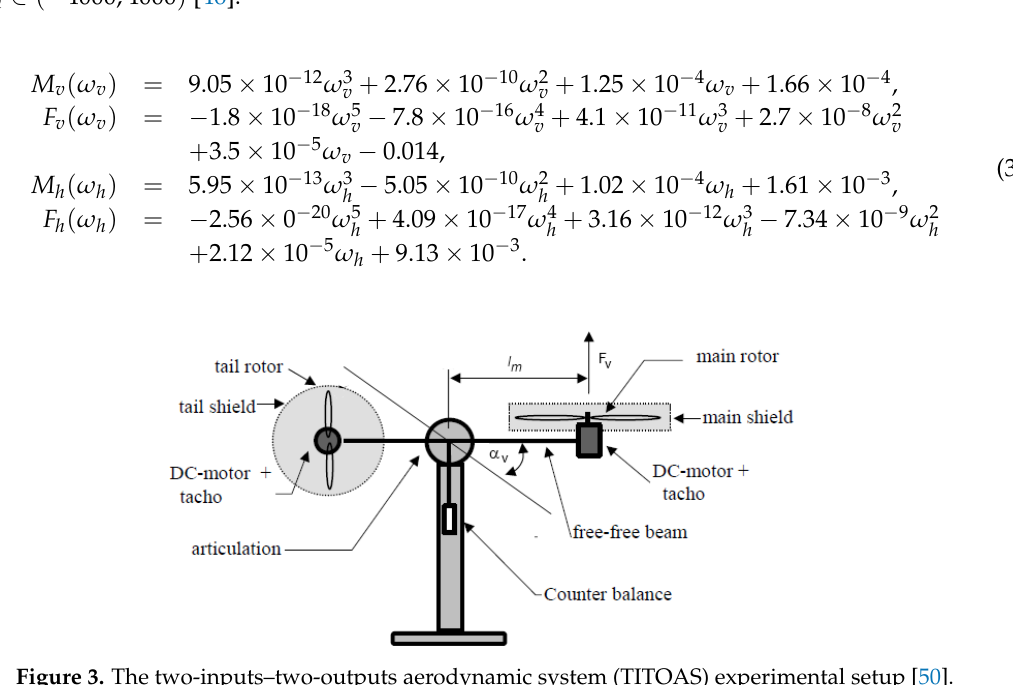
Figure 3. The two-inputs–two-outputs aerodynamic system (TITOAS) experimental setup